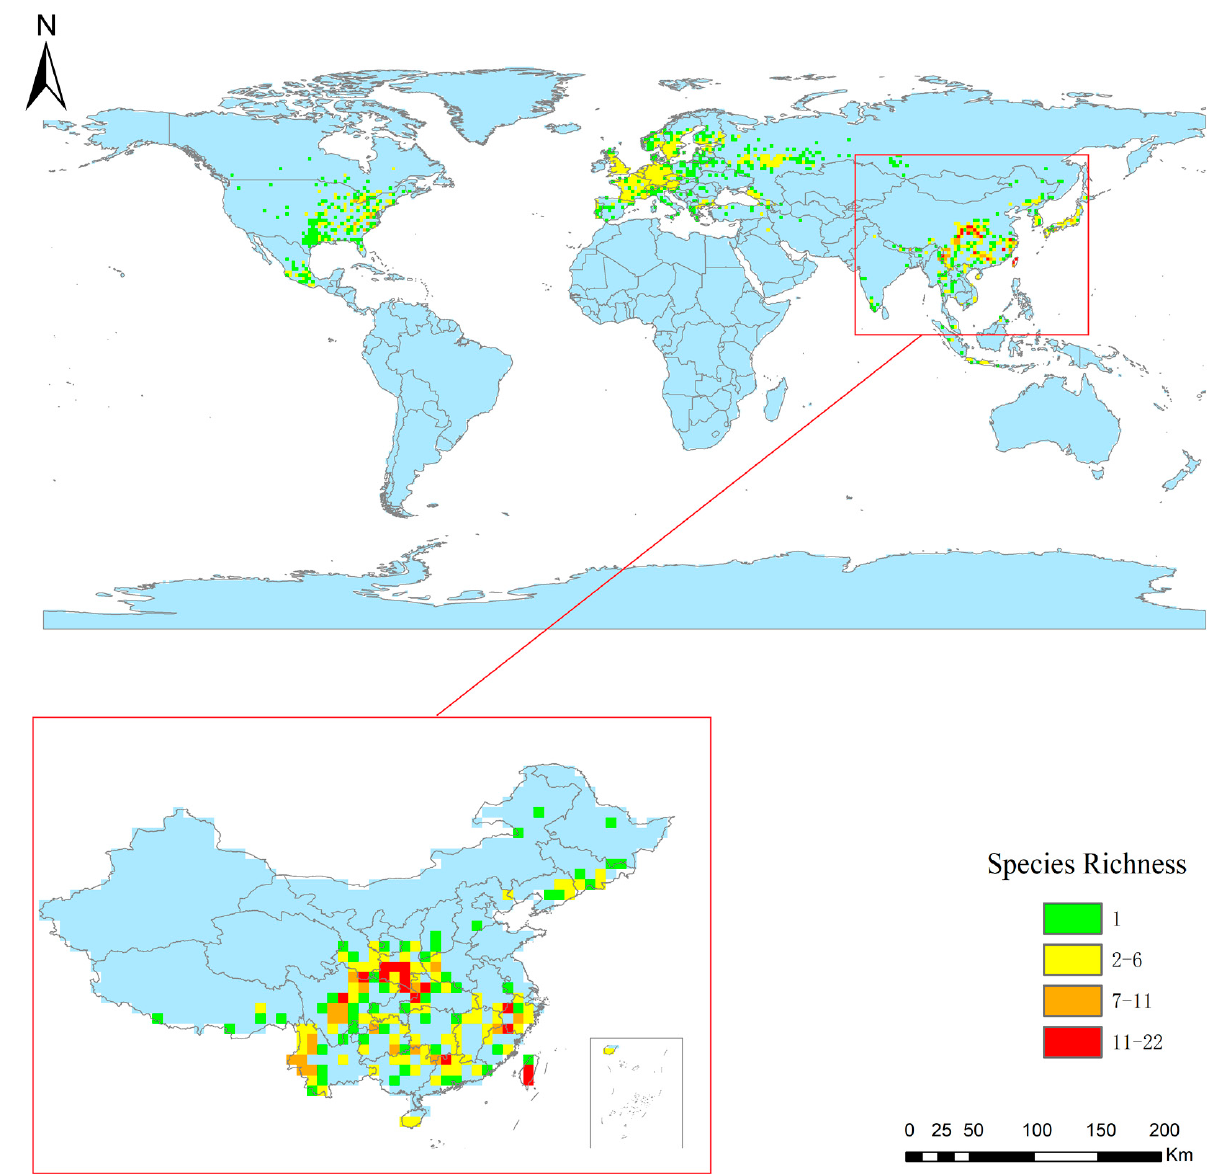
Figure 1. Species accumulation curves for Panorpidae based on bootstrap mean values.